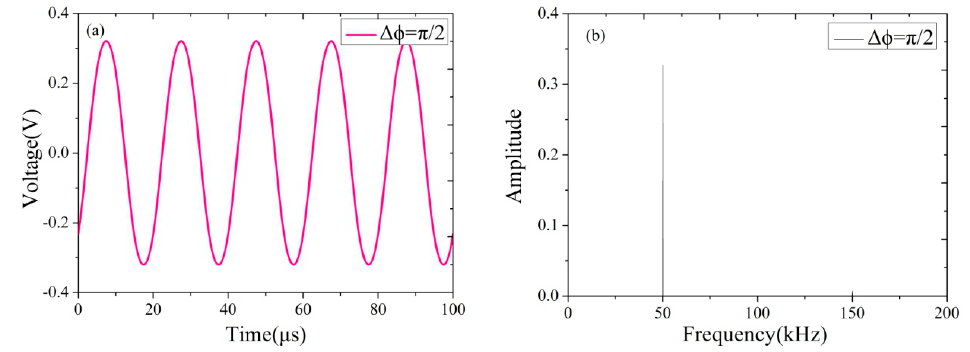
Figure 3. Output voltage with a phase modulation of ∆ φ = π /2 in the numerical simulation. ( a ) Output voltage waveform; ( b ) corresponding frequency spectrum.